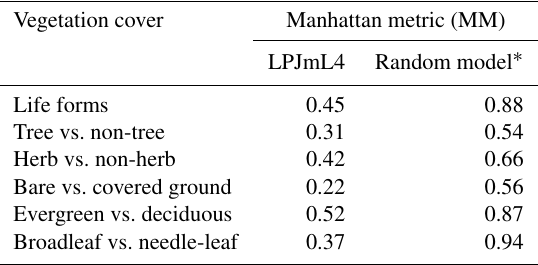
Table 3. Comparison metric scores for LPJmL4 simulations against observations of fractional vegetation cover data from International Satellite Land-Surface Climatology Project (ISLSCP) II vegetation continuous field (VCF) (Defries and Hansen, 2009).